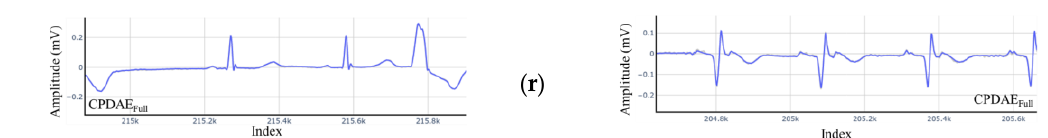
Figure 16. Comparison of the reconstructed results for various evaluated models in MLII of